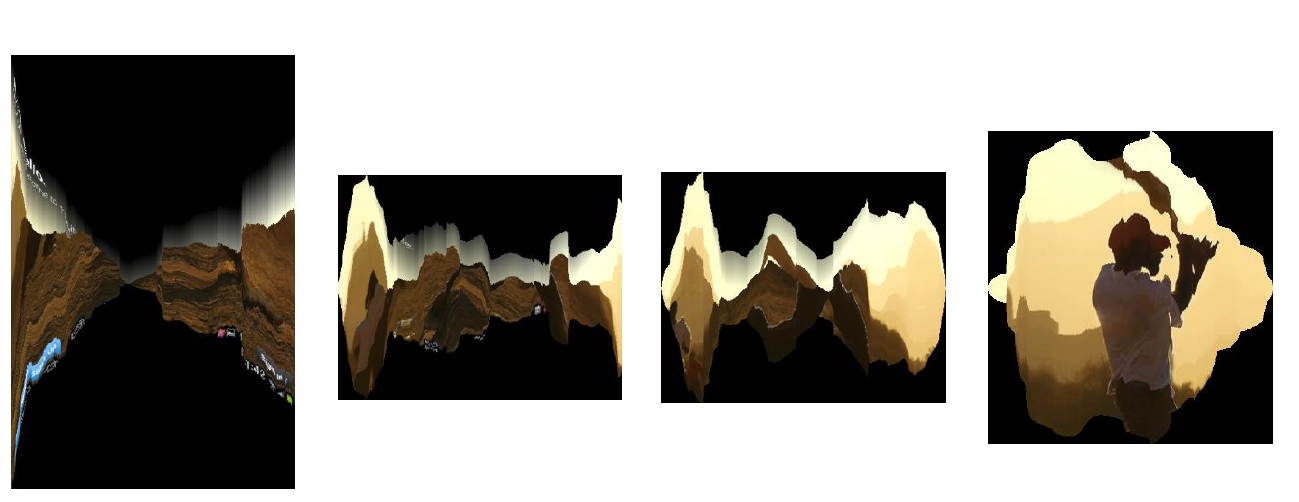
Figure 9. Compressed CovSal clusters. Table 1. CovSal cluster compressing algorithm.